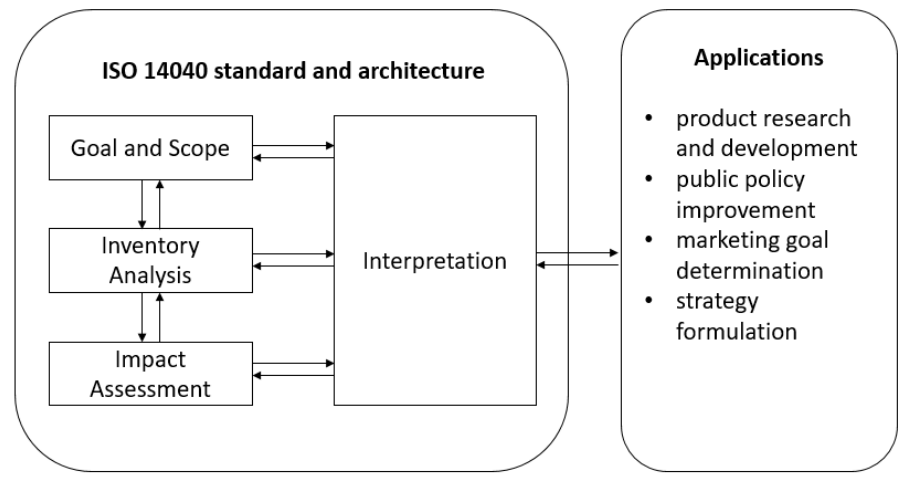
Figure 3. Life-cycle architecture.